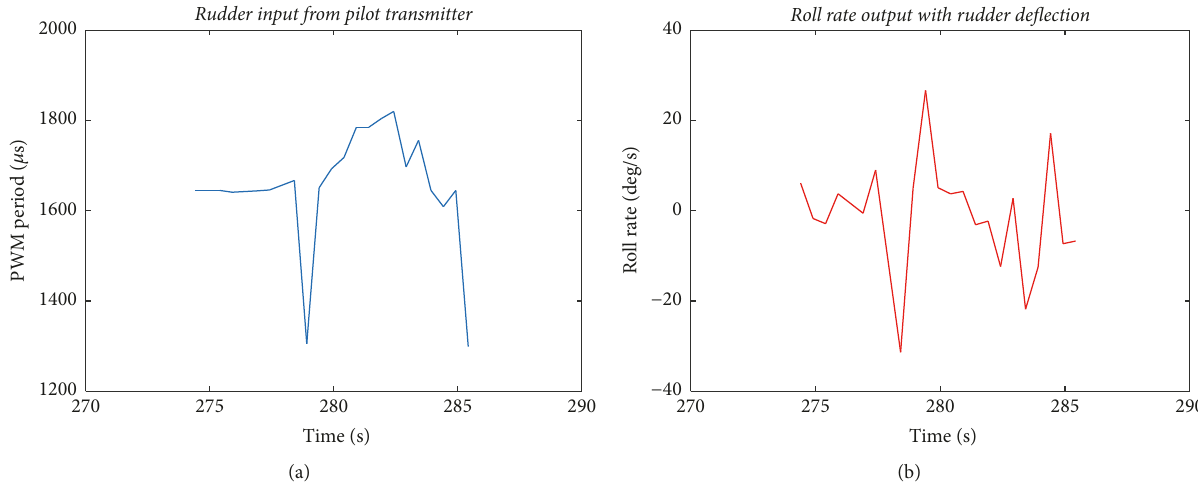
Figure 17: Roll rate of the FMW when given rudder doublets: (a) rudder inputs from pilot; (b) roll rates of the FMW mini-UAV. Wing warping input from pilot transmitter